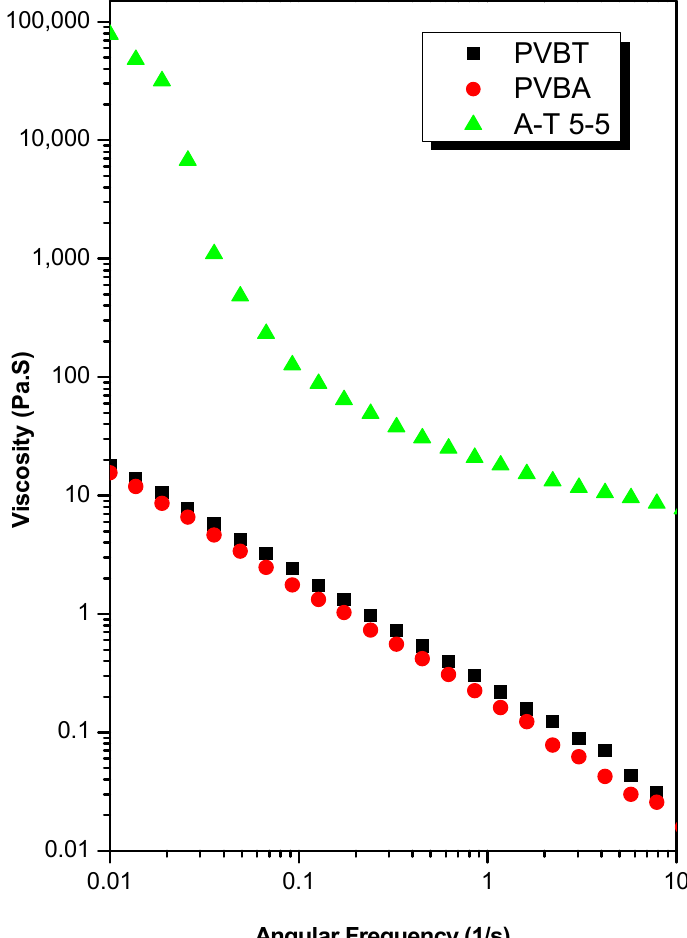
Figure 10. Apparent viscosities of ( a ) PVBT; ( b ) PVBA; and ( c ) the PVBT/PVBA = 50/50 blend complex.